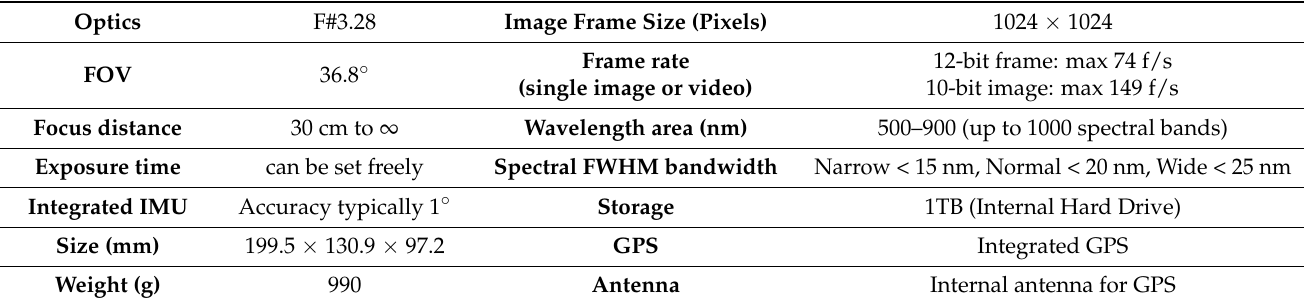
Table 3. Senop hyperspectral HSC-2 sensor